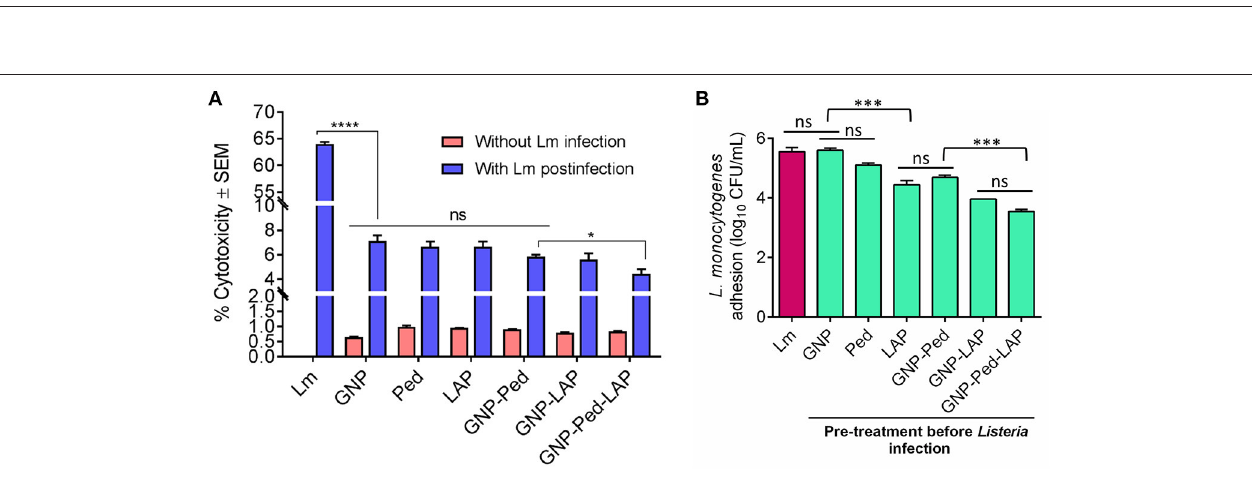
Frontiers in Sustainable Food Systems | www.frontiersin.org